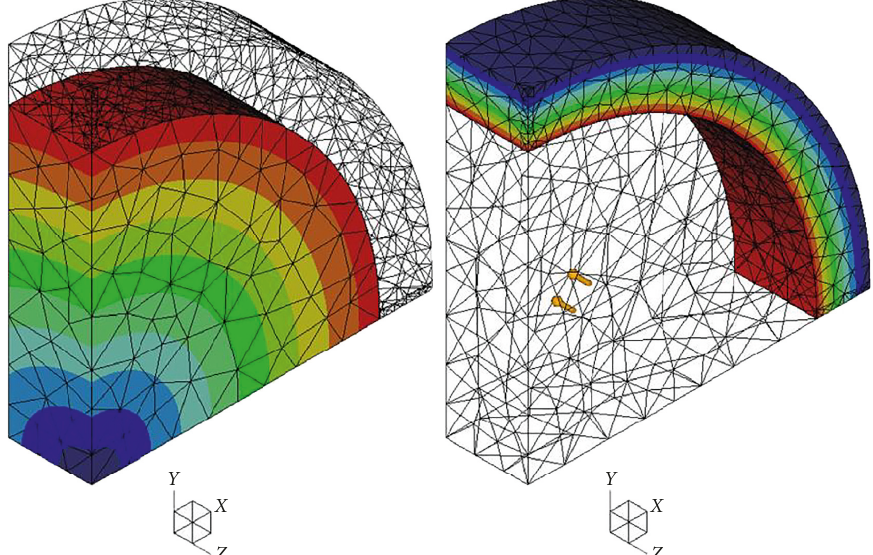
Figure 4: Displacement field (magnitude) of the shaft (left) and the hub with finite p-element mesh.